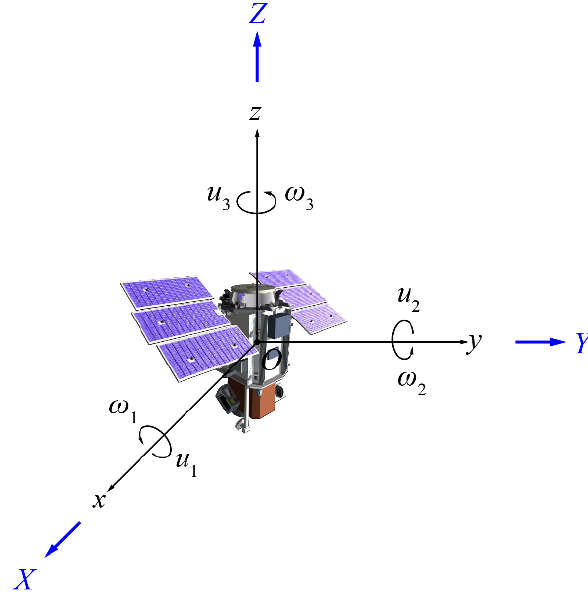
Figure 1. Illustration of the control torques and angular velocity